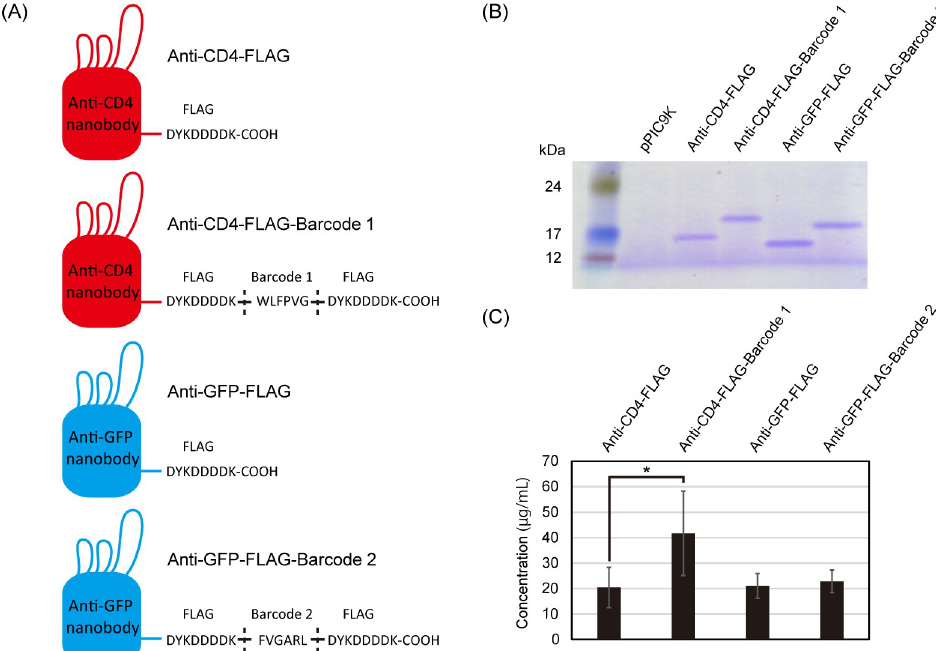
Fig 2. Generation of functional nanobodies fused with peptide barcodes. (A) Design of nanobodies used in this study. A unique peptide barcode was fused at the C-terminal of each nanobody. These peptide barcodes were designed to have high detectability for LC–MS analysis. (B) SDS-PAGE analysis of the nanobodies produced by Pichia pastoris . The culture medium was applied to an SDS-PAGE gel, and proteins were stained by Coomassie Brilliant Blue. pPIC9K is a backbone vector used as a negative control. (C) The productivity of the nanobodies by P . pastoris . Each value represents the mean ± standard deviation of at least five biological replicates. Statistical analysis was performed by t - test. An asterisk indicates a significant difference (p < 0.05).